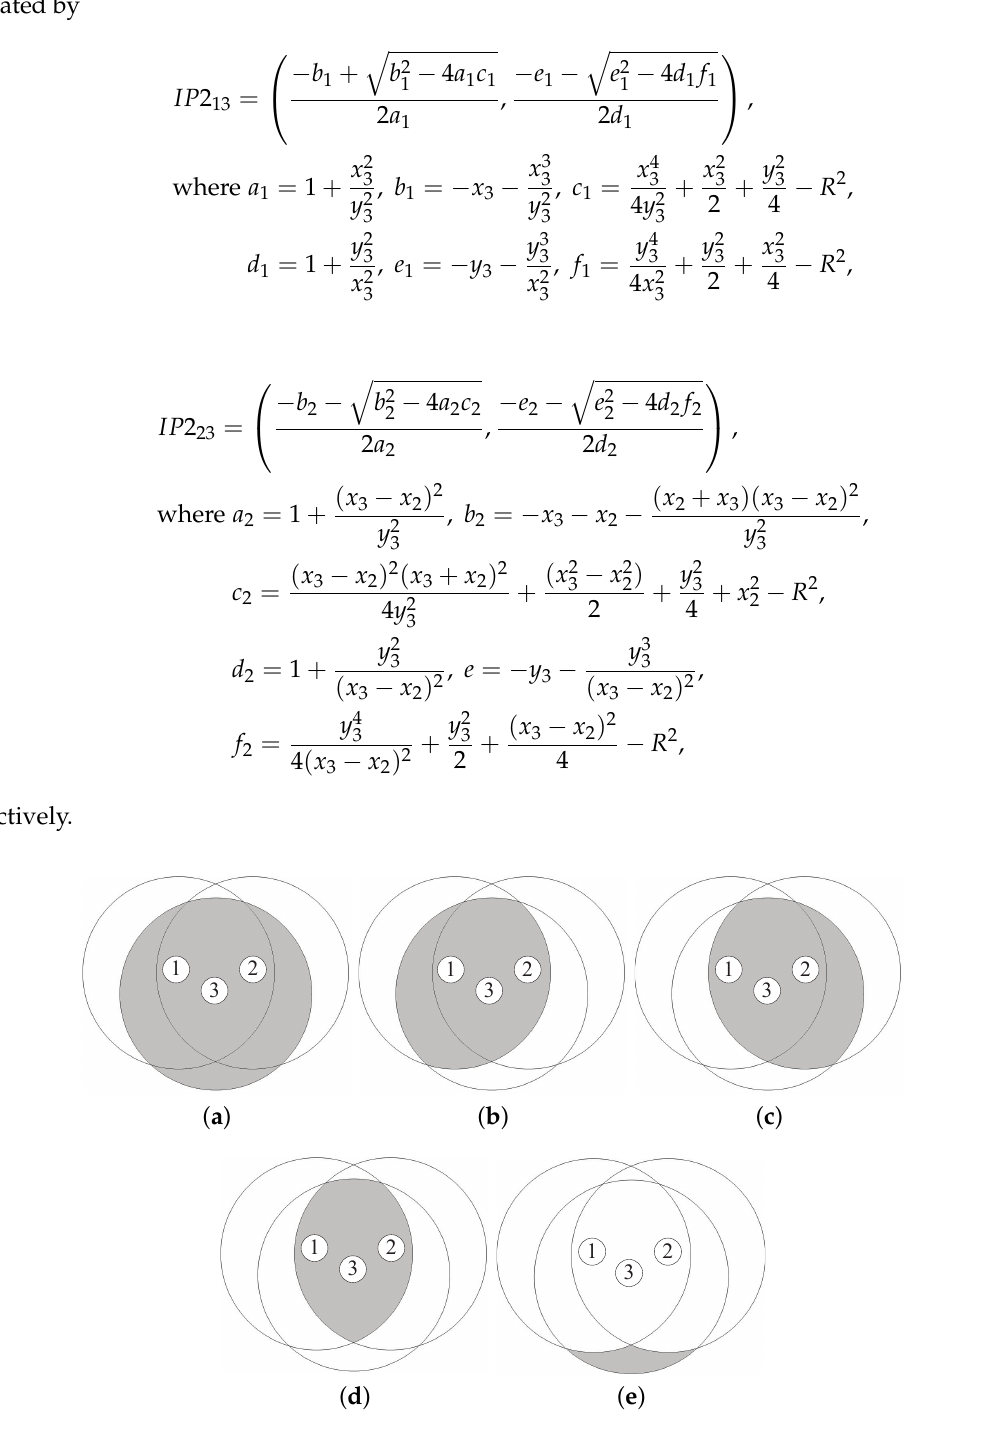
Figure 9. The additional coverage area of node 3 in case 3. ( a ) TA 3 ; ( b ) IA 13 ; ( c ) IA 23 ; ( d ) IA 123 ; ( e ) AC 3